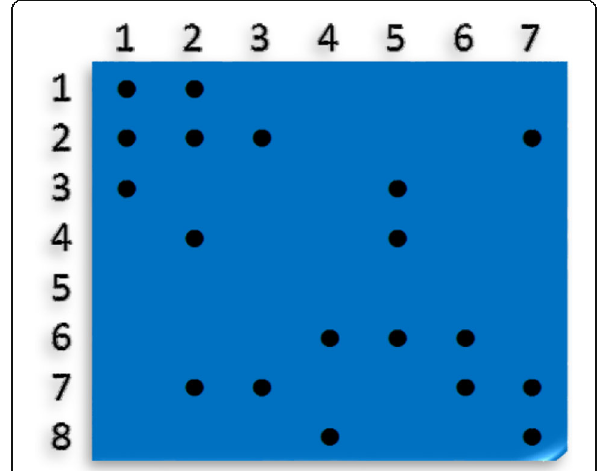
Fig. 8 The simulated RGB mode of the coded dot matrix model in a black color of color laser Ricoh ® SP C 420 DN sample